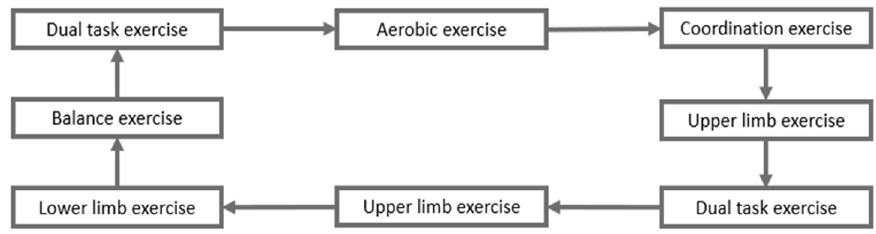
Figure 2. Example of the organization of the CT-c